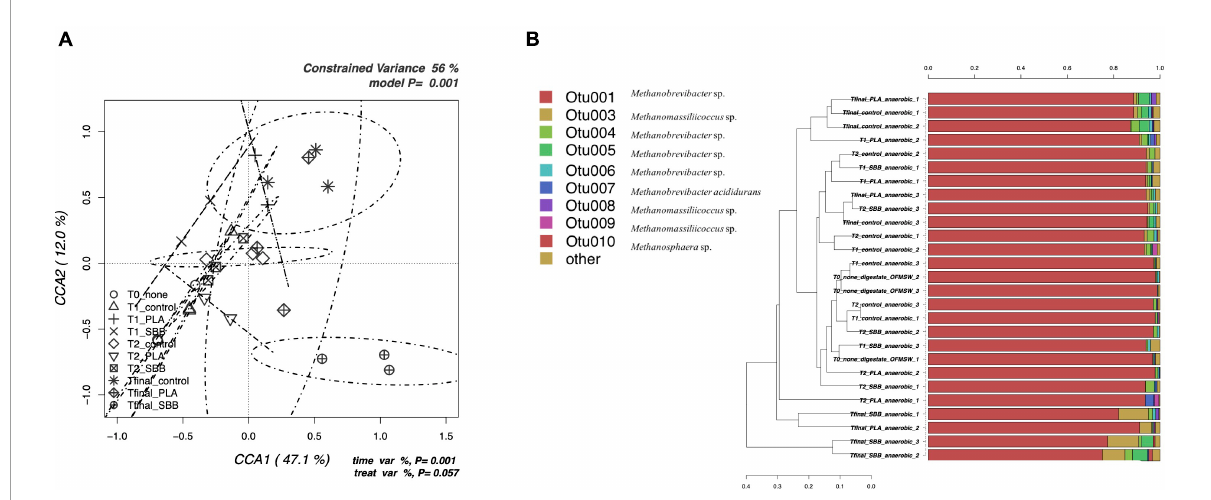
FIGURE3 Archaeal community during anaerobic digestion. (A) Hypothesis-driven canonical correspondence analysis (CCA) model performed on the total archaeal OTUs relative abundance data from anaerobic digestion intermediate samples. (B) Overview and identification of the most abundant OTUs comprising 99% of the archaeal diversity in anaerobic digestion intermediate samples. PLA, polylactic acid; SBB, starch-based bioplastic; OFMSW, organic fraction of municipal solid